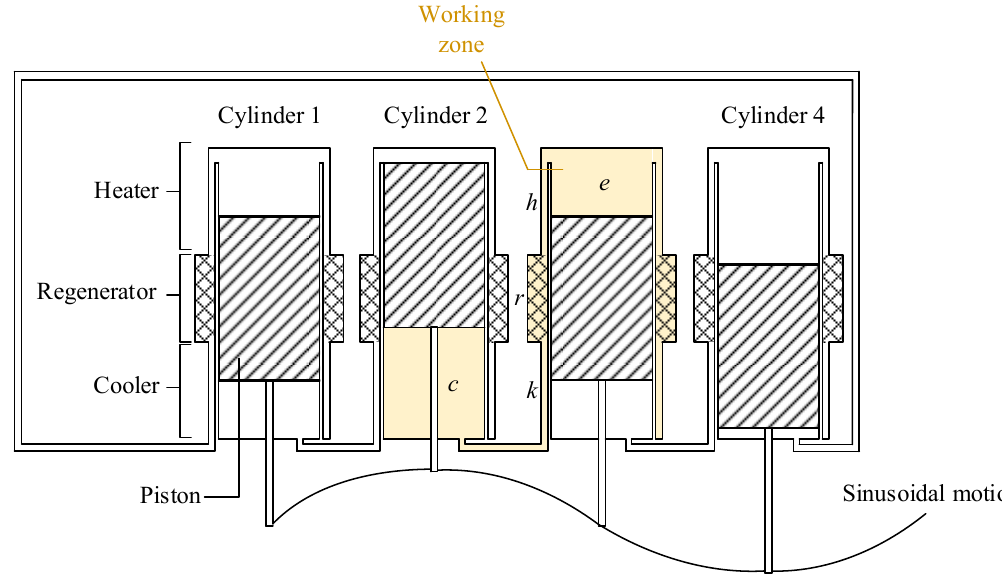
Figure 1. Schematic of the four-cylinder double-acting α -type Stirling engine.